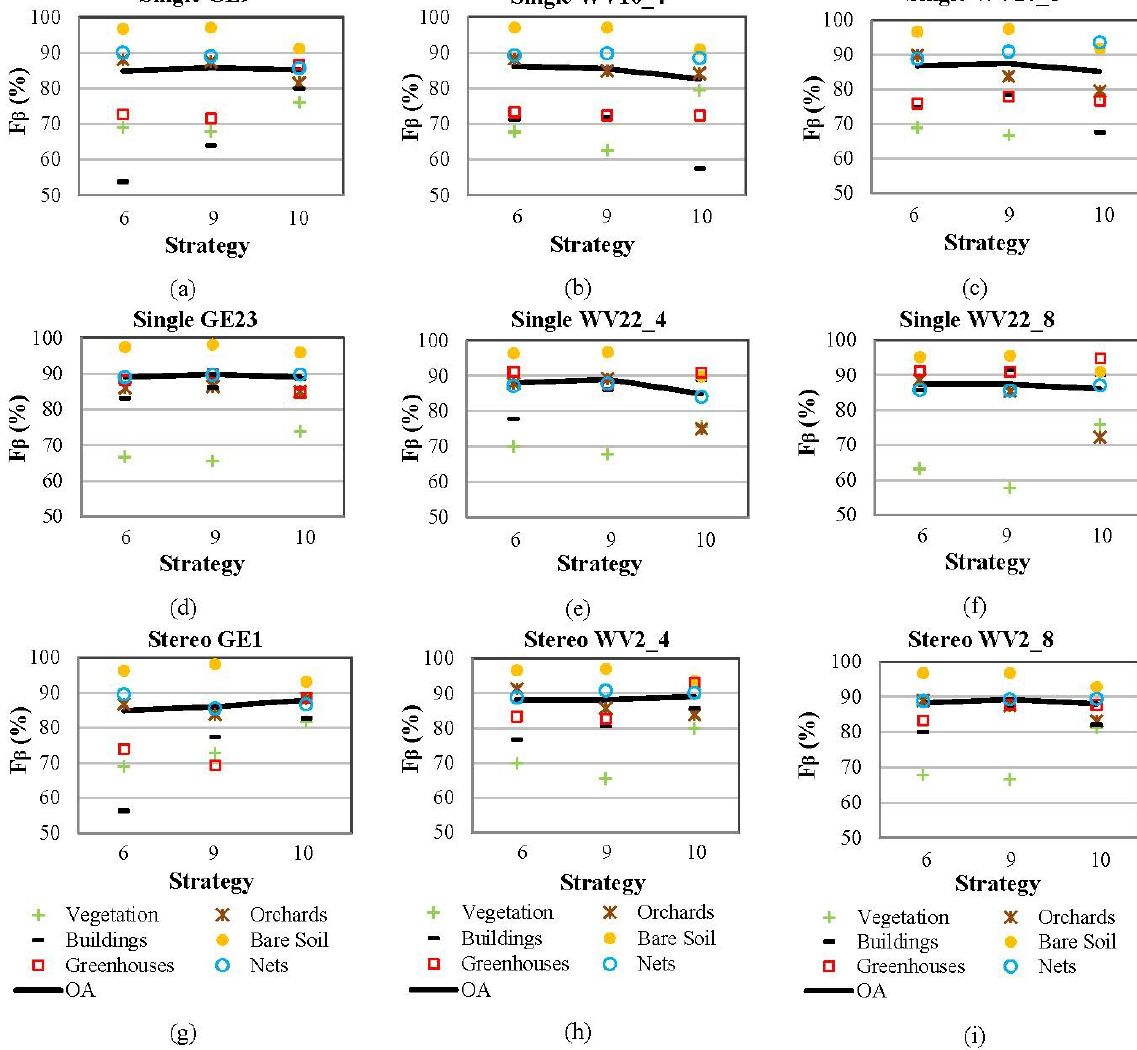
index (NN classifier and β